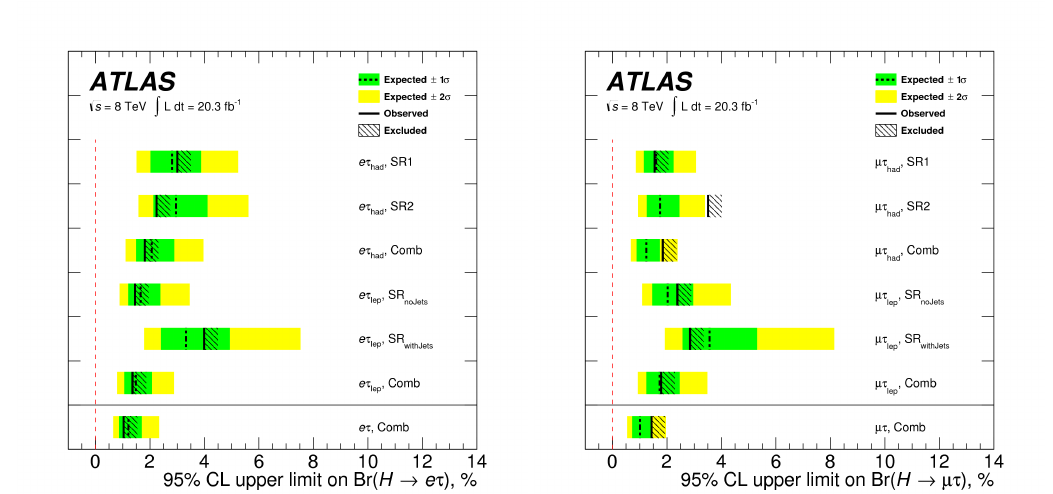
Figure 3: The expected and observed upper limits for branching ratios of H → e τ (left) and H → µτ (right) decays [ 11 ]